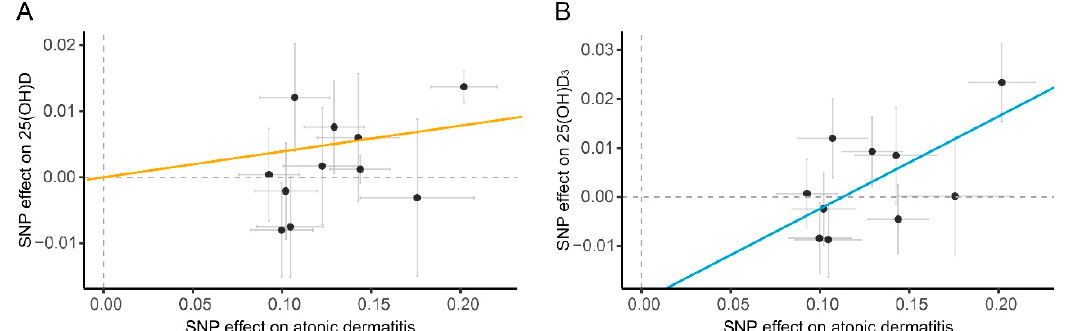
Figure 4. Scatter plots of genetic effects of IVs on vitamin D levels and the risk of atopic dermatitis. The genetic effects of IVs on ( A ) 25(OH)D levels, ( B ) 25(OH)D 3 and the risk of atopic dermatitis. The x -axis denotes genetic effects of instruments variables (IVs) on exposure while the y -axis depicts genetic effects of IVs on outcome. The slope of the solid line represents the causal estimation in inverse-variance weighted methods (orange) and MR-Egger methods (blue) of MR analyses. The vertical and horizontal dashed lines denote genetic effect β = 0 for exposure and outcome, respectively. The gray bar depicts the standard error for each genetic effect estimation. Abbreviations: 25(OH)D: 25-hydroxyvitamin D; 25(OH)D 3 : 25-hydroxyvitamin D 3 ; SNP: single nucleotide polymorphism .